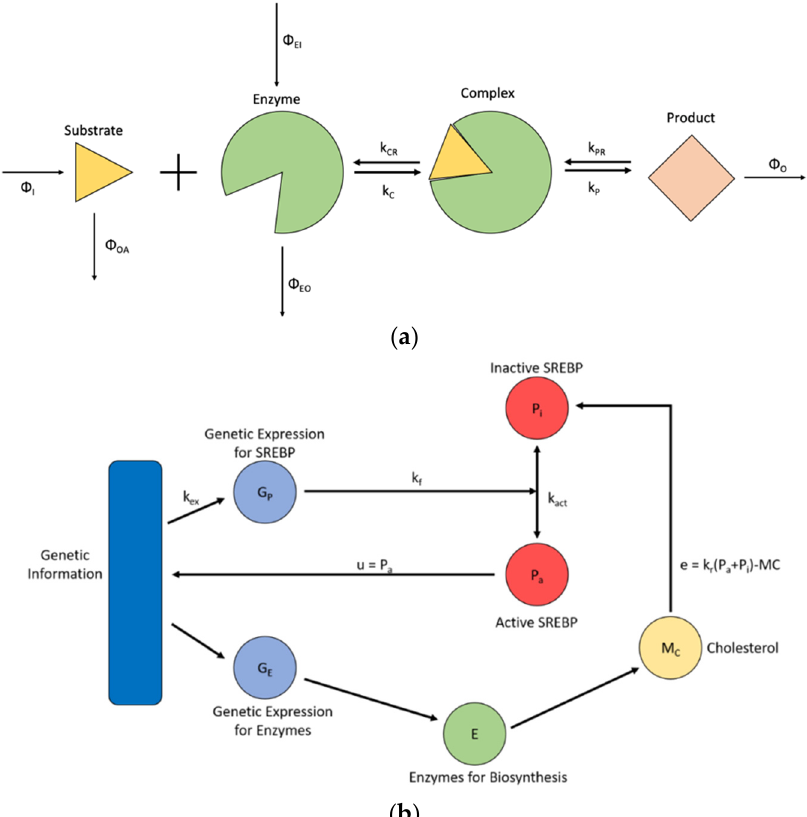
Figure 3. Model for steady state cholesterol biosynthesis (Model 2): ( a ) the substrate binds to the enzyme to form a complex before the enzyme catalyzes the reaction of substrate to product; ( b ) simplified diagram of SREBP regulation. A lack of cholesterol makes SREBP active, allowing it to aid in transcription. The active SREBP influencing the transcription is the control signal, while the cholesterol causing the SREBP to become inactive (i.e., Pi) is the control signal error. Equations of Model 2, along with mentioned parameters, are shown A8 through A15 in Appendix A [38].